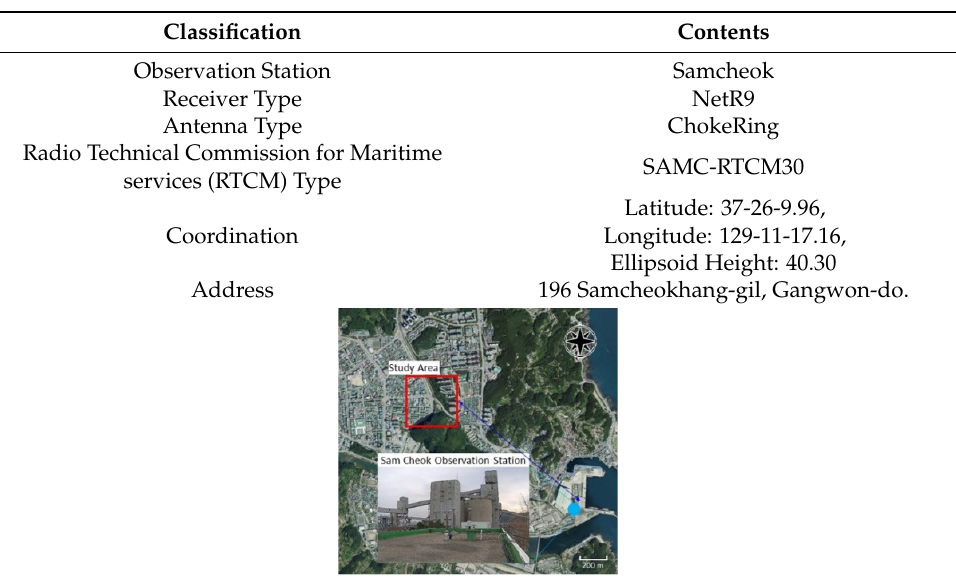
Table 4. Condition of the Global Navigation Satellite Systems (GNSS) observation station.